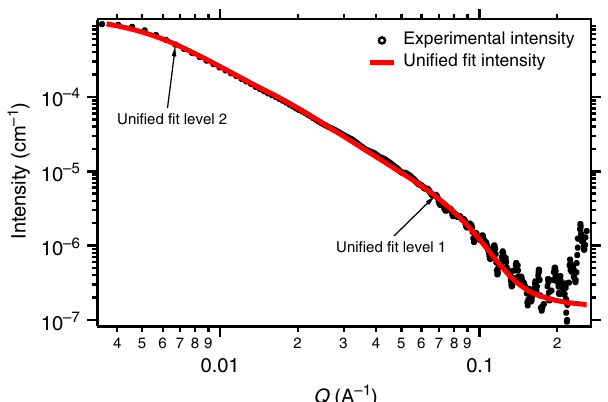
Fig. 4 SAXS curve of tungsten blue oxide particles in helium measured at ESRF. The signal is derived by averaging the SAXS curves after applying the differential background subtraction (DBS). A uni fi ed two-level Beaucage fi t (red line) nicely reproduces the shape of the SAXS curve. The coef fi cients of the fi t are reported in Table 1. Additionally the position of structural levels 1 and 2 are indicated in the graph as well